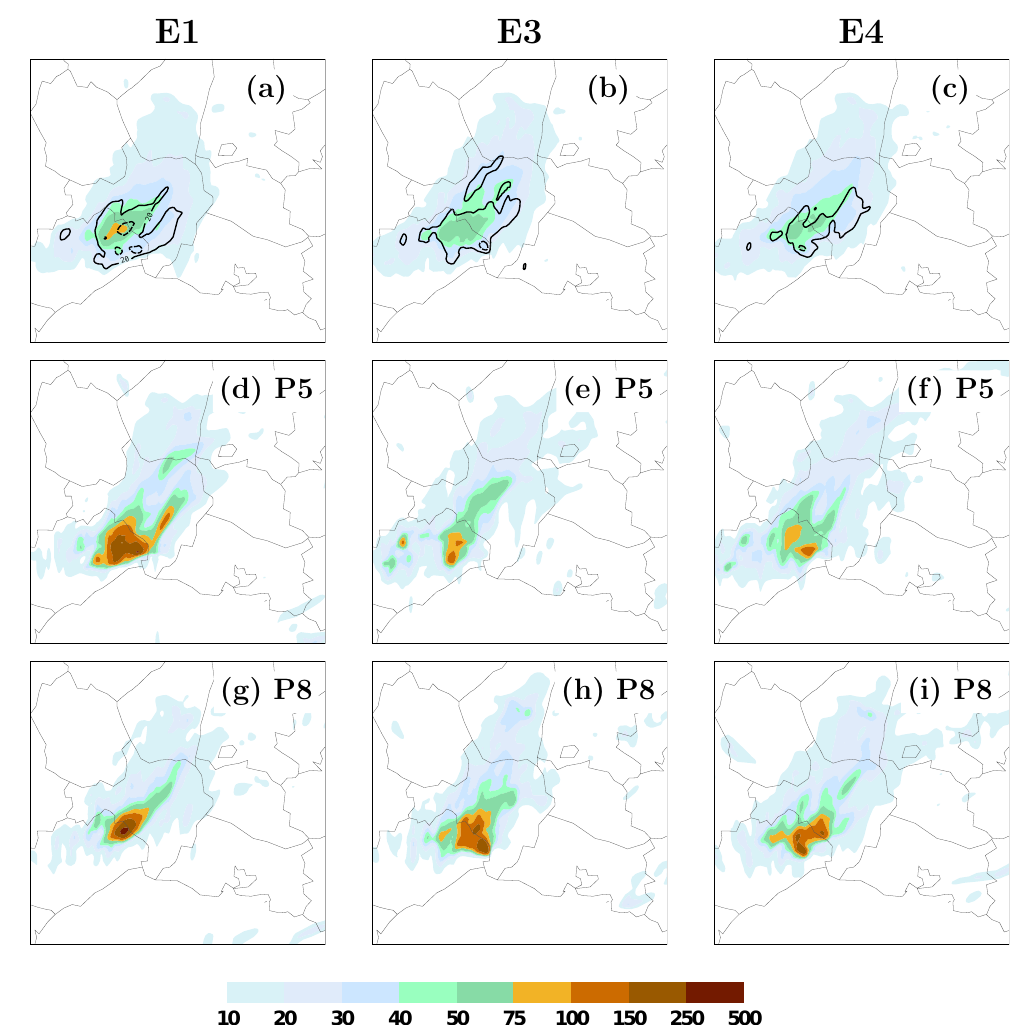
Fig. 8. Same as Fig. 6, for Case 1 at 00:00 UTC 21 October 2008, for members 5 (d–f) and 8 (g–i)